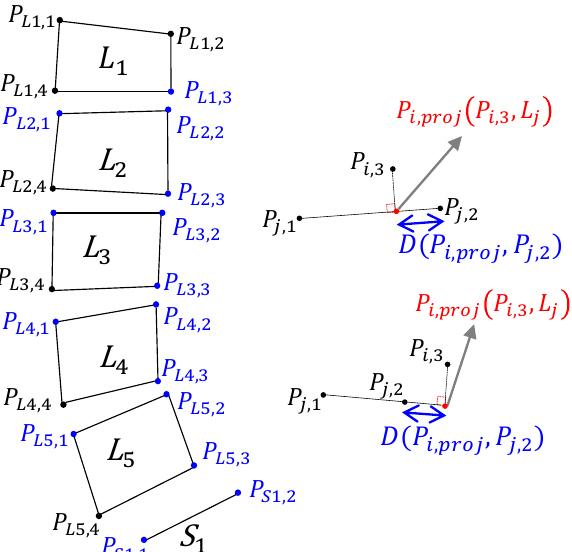
Figure 6. Five lumbar vertebrae with four points and the sacrum with two points. The projected point may lie either within or beyond the segmented